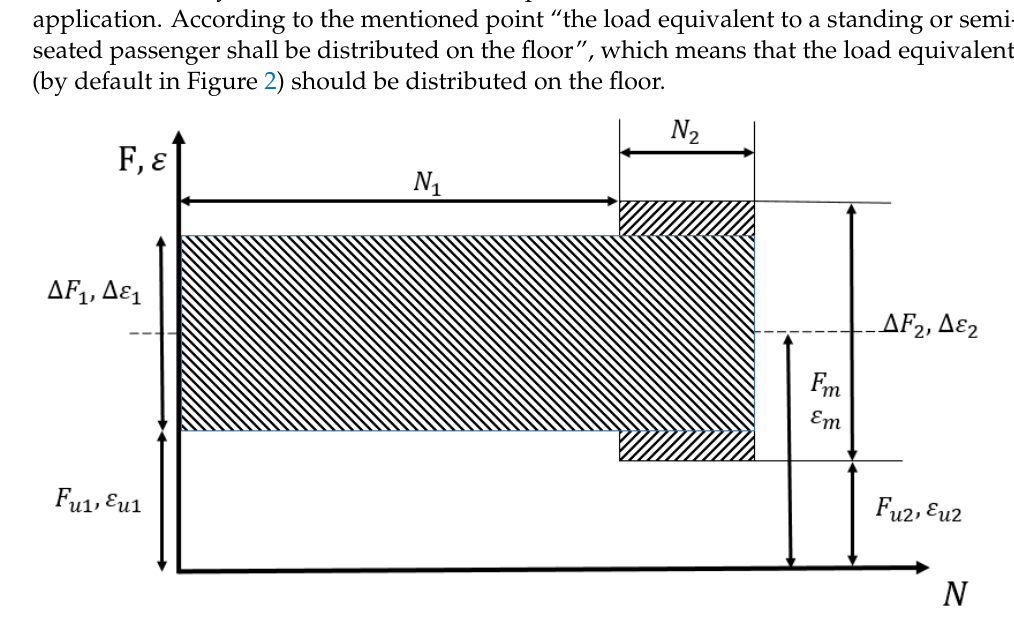
Figure 2. Test parameters for circular overhead railways with detachable headstocks